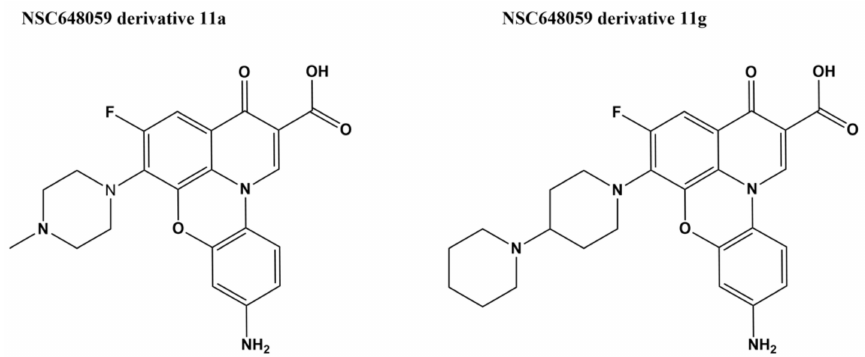
Figure 6. Structures of fluoroquinophenoxazine 11a and 11g [114].